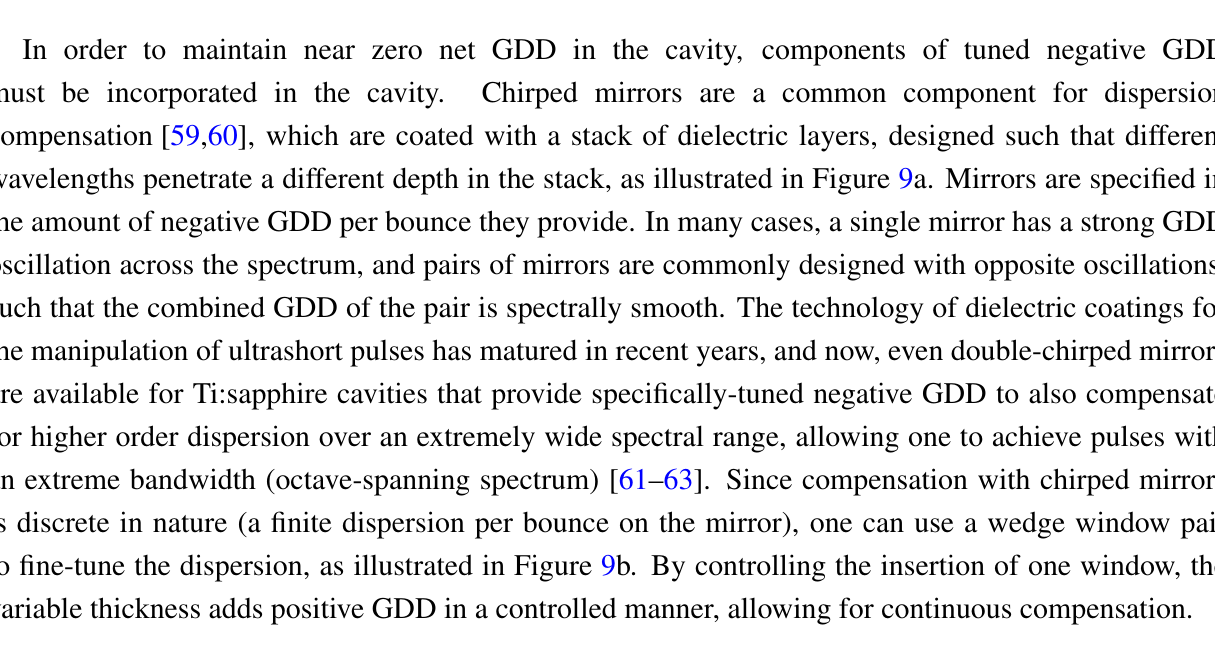
Figure 9. Dispersion compensation devices: ( a ) chirped mirrors; ( b ) a pair of wedged windows; ( c ) a pair of